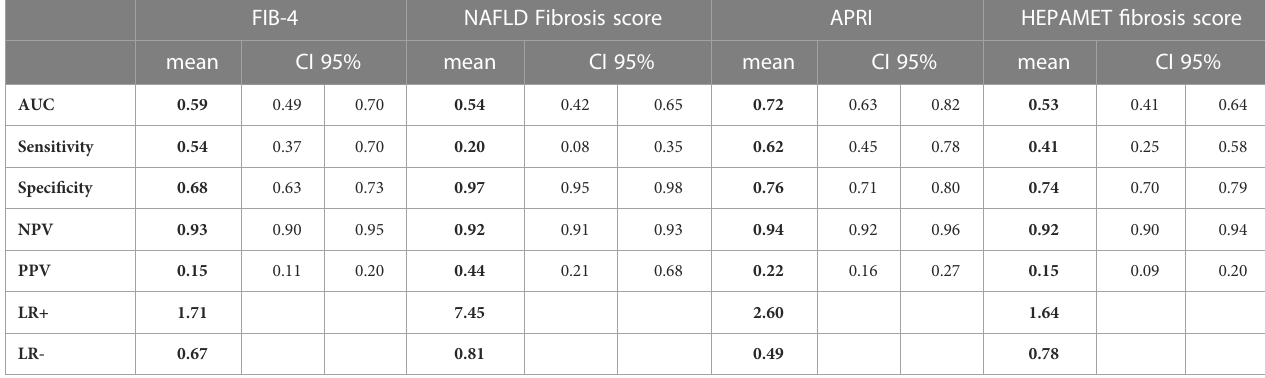
TABLE 5 Accuracy evaluation of non-invasive fi brosis scores compared to TE.